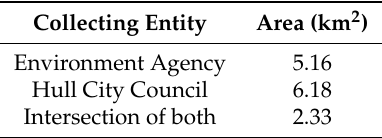
Figure 3. Identified flooded areas. Light blue: EA only. Dark blue: HCC only. Green: intersection of both administrations. Table 3. Comparison of identified flood